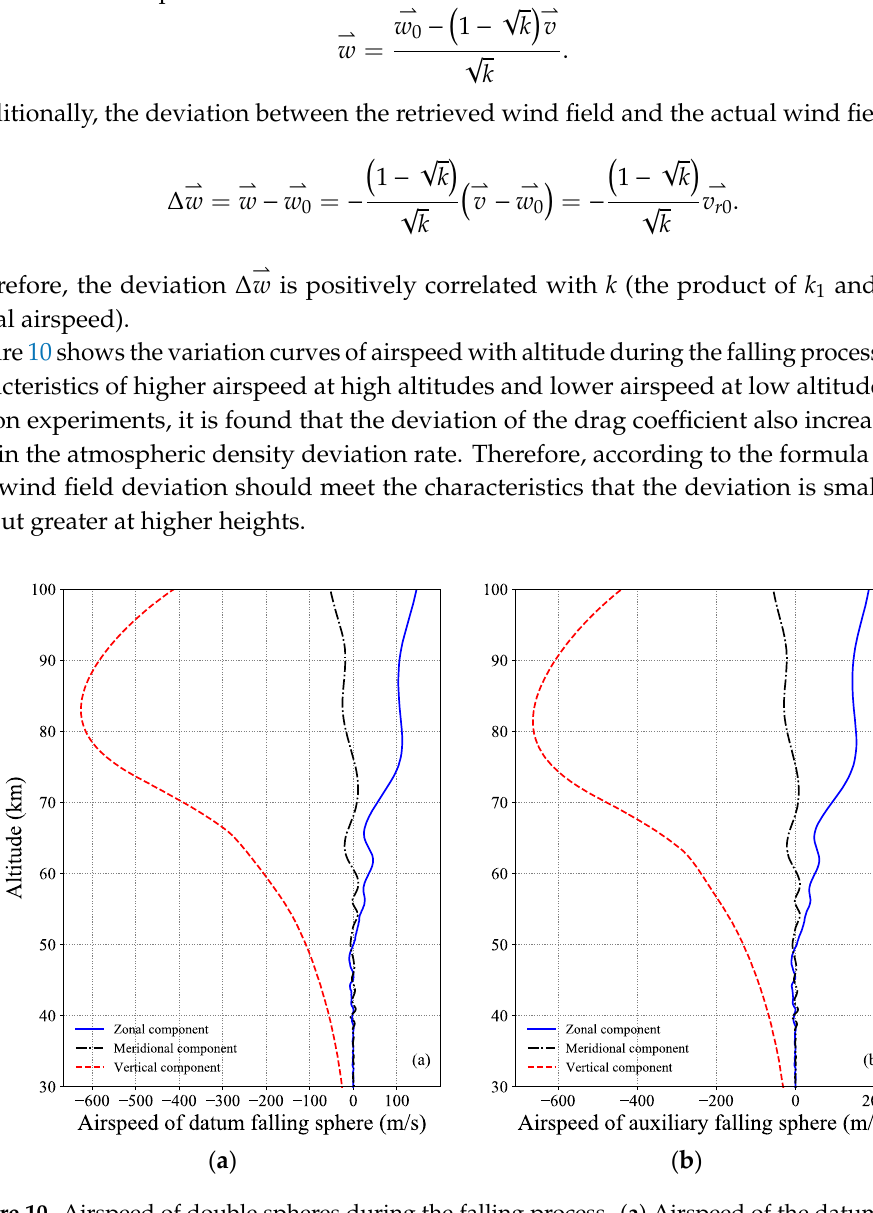
Figure 10. Airspeed of double spheres during the falling process. ( a ) Airspeed of the datum falling sphere; ( b ) airspeed of the auxiliary falling sphere.